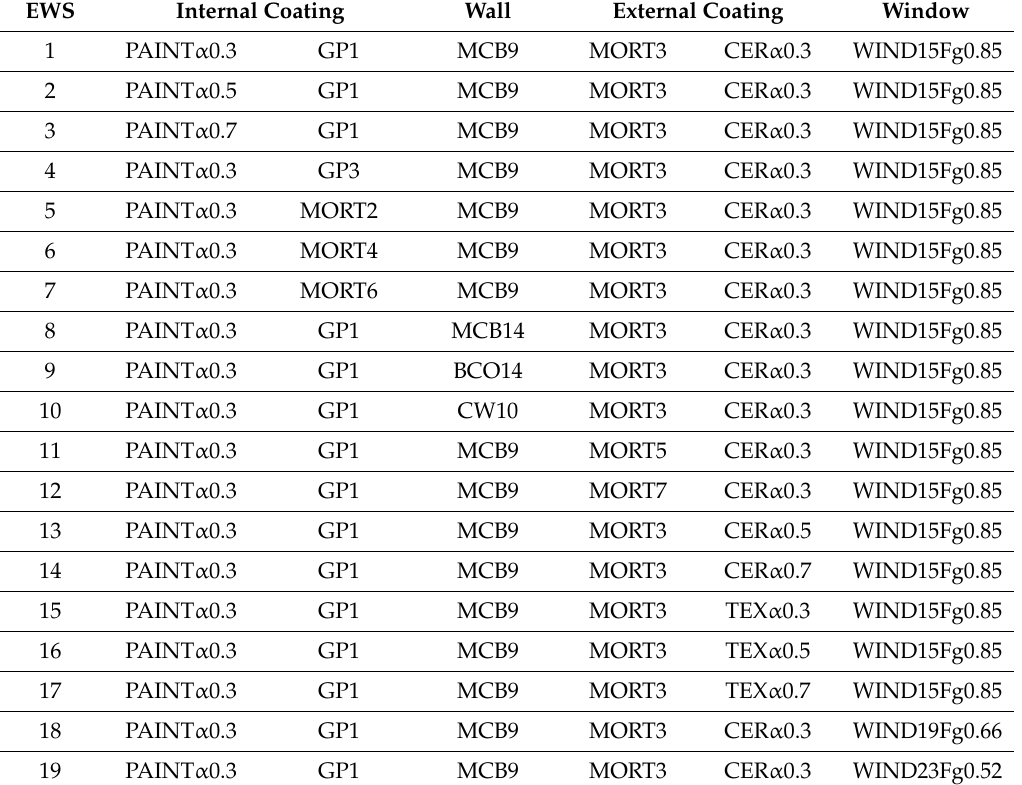
Table 9. External wall systems (EWS) considered in numerical simulations.